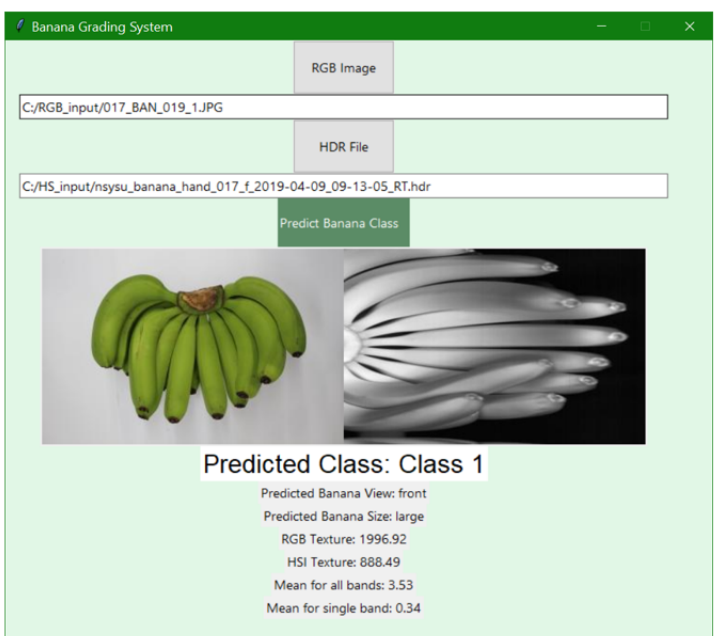
Figure 8. Screenshot of the user interface of the Banana Grading System developed in this study.